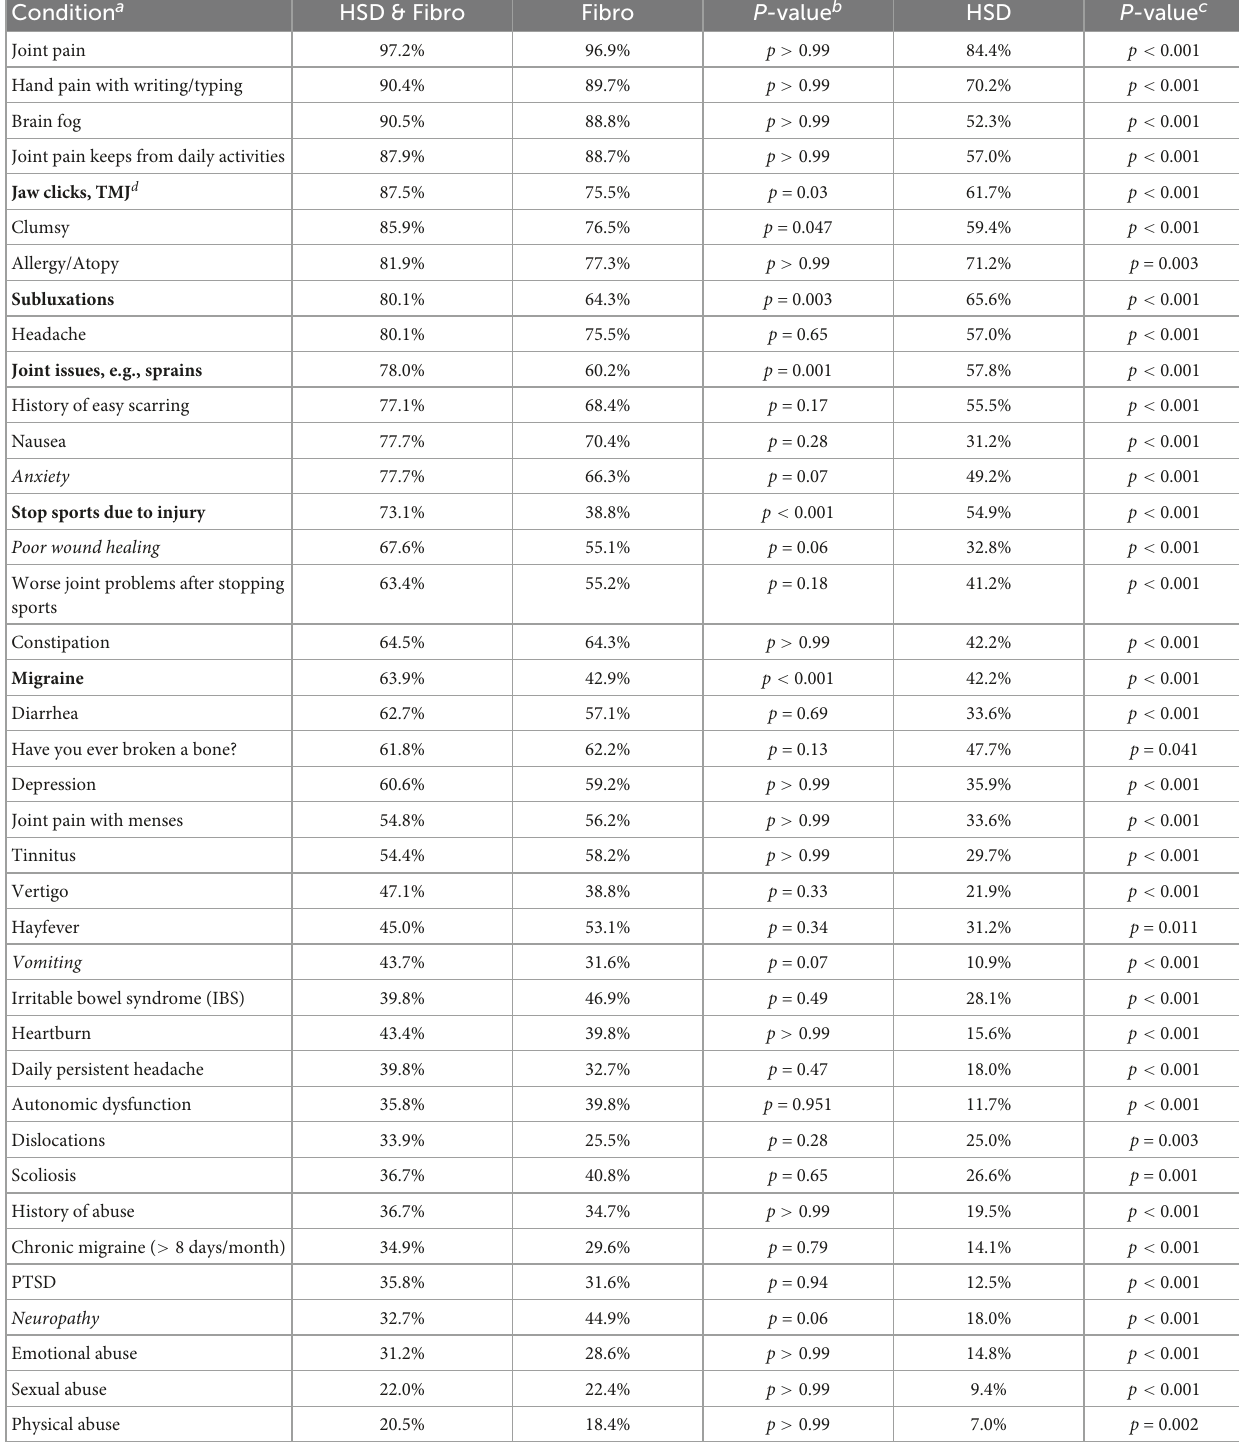
TABLE 9 Comparison of HSD&Fibro ( n = 327) to Fibro ( n = 98) or HSD ( n = 128) in men and women. Condition